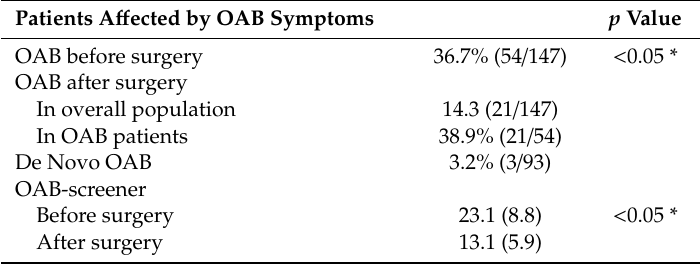
Table 3. Functional outcomes on OAB.